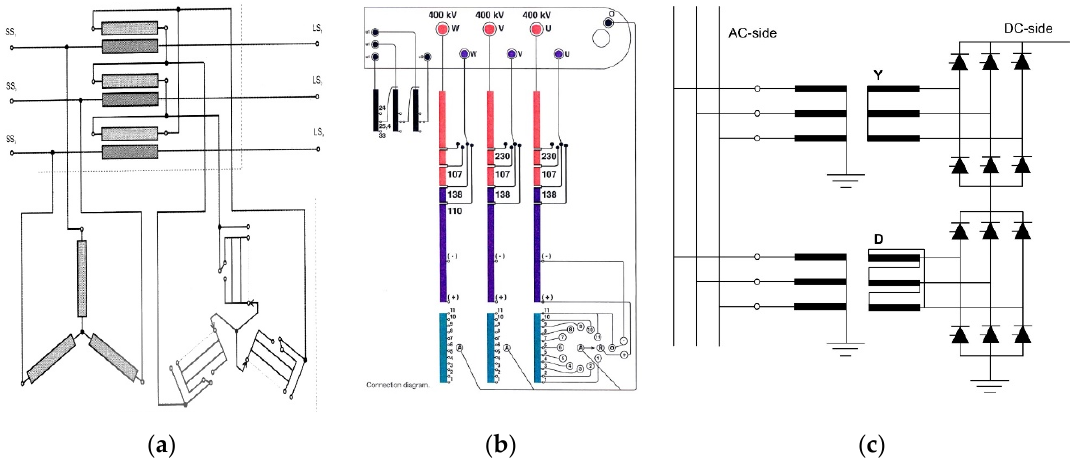
Figure 1. Transformers for power system control ( a ) phase-shifting transformers ( b ) multilevel autotransformer ( c ) HVDC transformer.